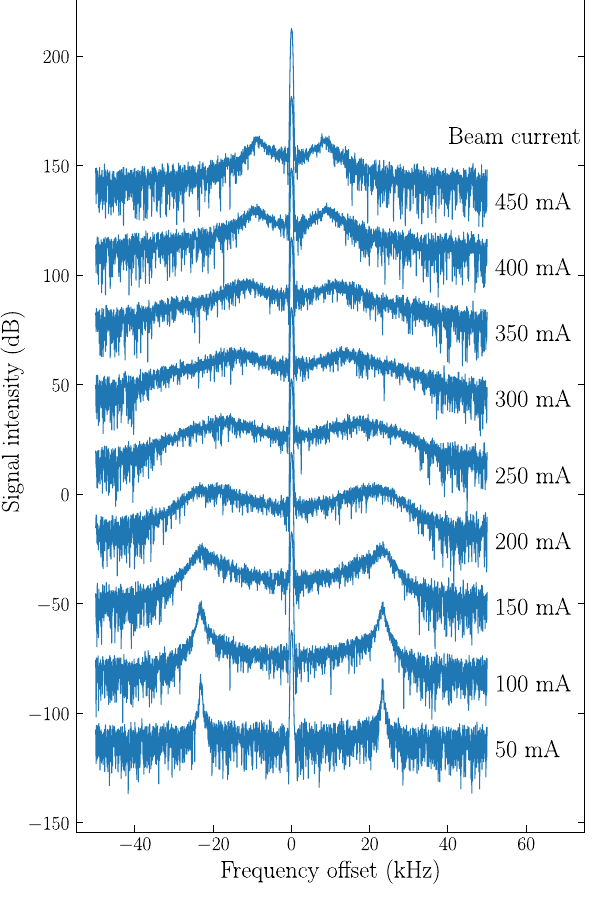
FIG. 10. Beam responses measured under different beam currents. The total cavity voltage was fixed at 1.70 MV. To separate the traces, an offset of 30 dB was appended between neighboring traces. The center frequency corresponds to an rf frequency of 500.106 46 MHz at this measurement. Each trace was obtained by a single sweep without averaging. The resolution bandwidth (RBW) of the spectrum analyzer was 300 Hz. The phase-modulation amplitude was 0.23° p-p. Measurement date: May 23, 2019.